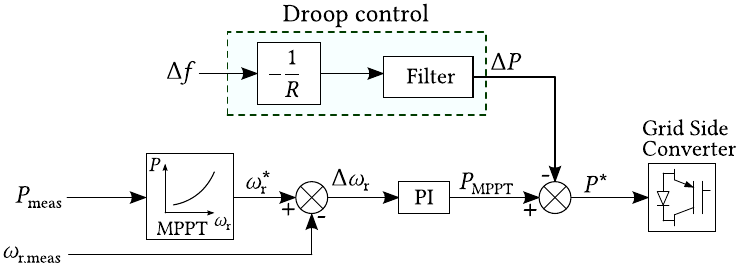
Figure 14. Frequency droop control for variable-speed wind